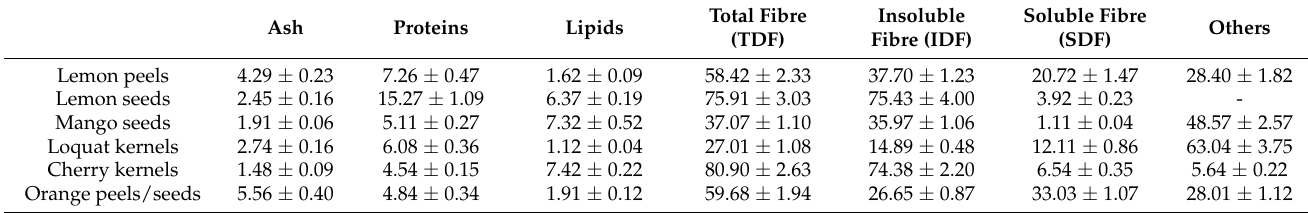
Table 1. Proximate composition of fruit by-products as such, namely ground seeds, kernels and peels, expressed as percentage on dry matter (%DM). “Others” = obtained by difference, comprising digestible carbohydrates. Analyses have been performed in duplicate and the results are expressed as mean ± SD.